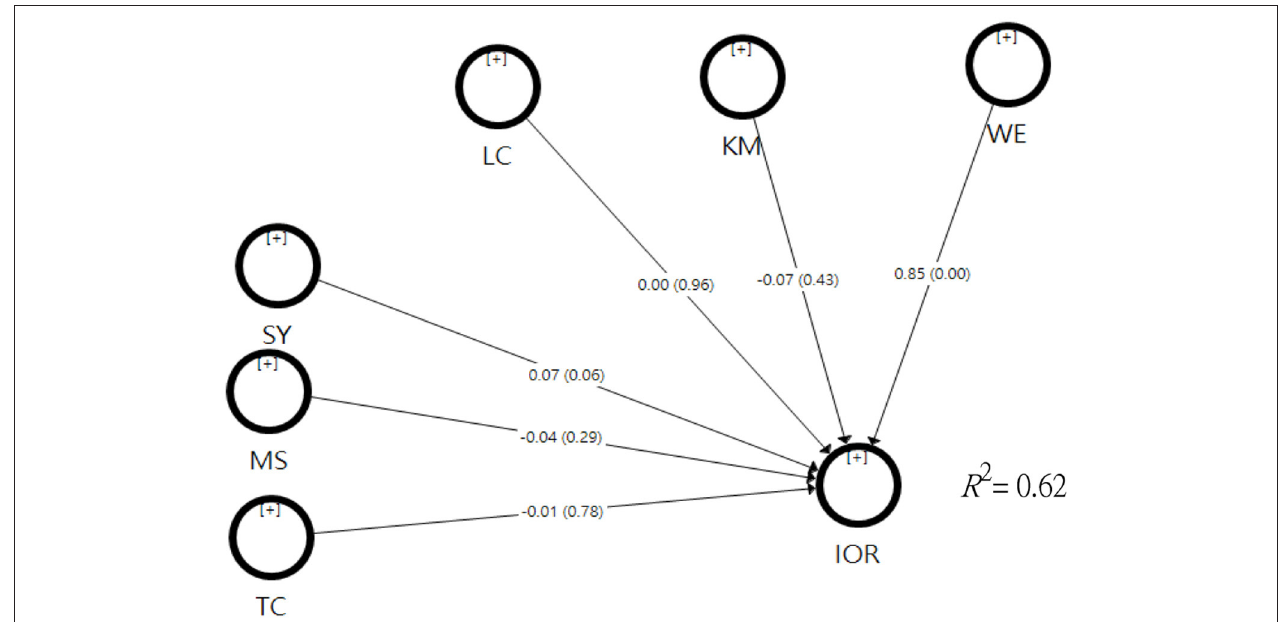
FIGURE 3 | Test results of the organizational factors hypothesis